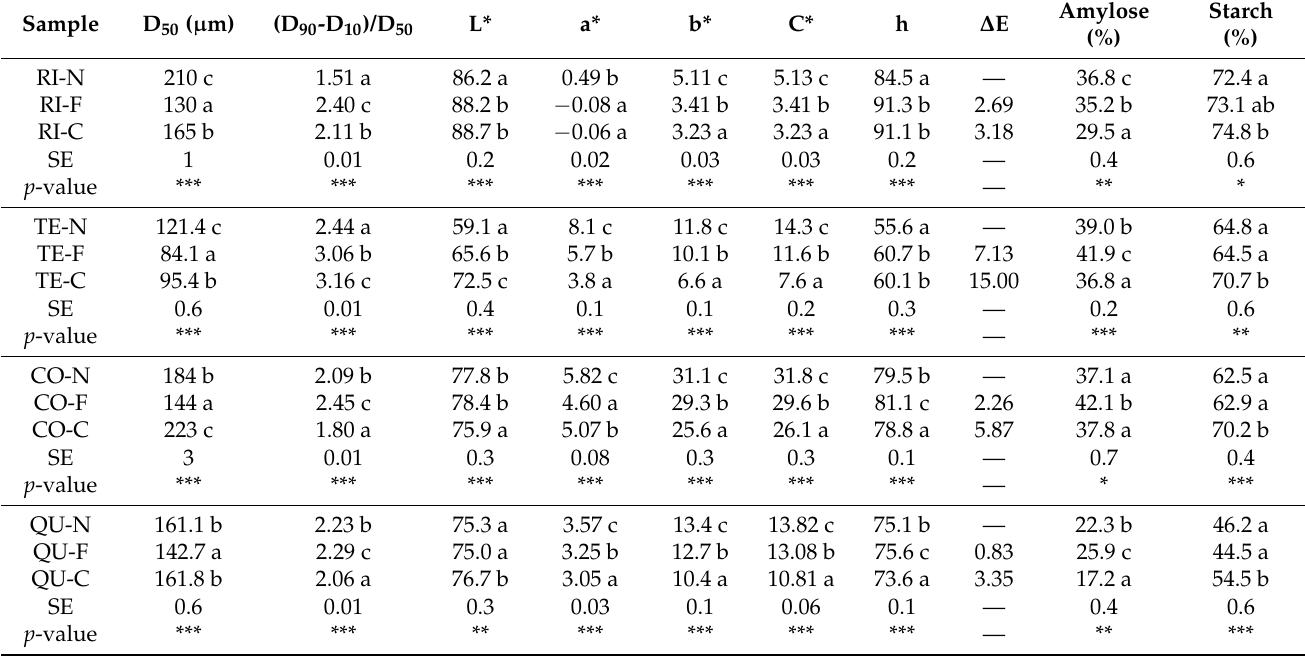
Table 2. Physical properties of native and modified rice, tef, corn and quinoa